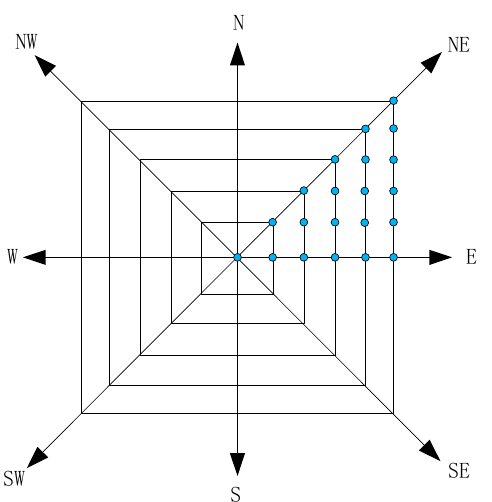
Figure 8. DEM data were divided into eight sub-regions. Each sub-region is rotationally symmetric (or mirror symmetric) with another sub-region with corresponding distance relationship between the data points.